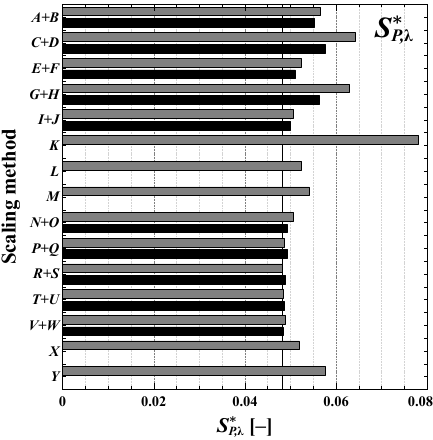
Figure 3. Standard deviation S ∗ of the normalized model–ship power correlation factor C ∗ P , λ all scaling methods λ . If the same scaling method was investigated with and without scaling to the Reynolds number of the self-propulsion test, the results are grouped together, the black bar stands for no scaling to the self-propulsion test. The capital letters reference Table